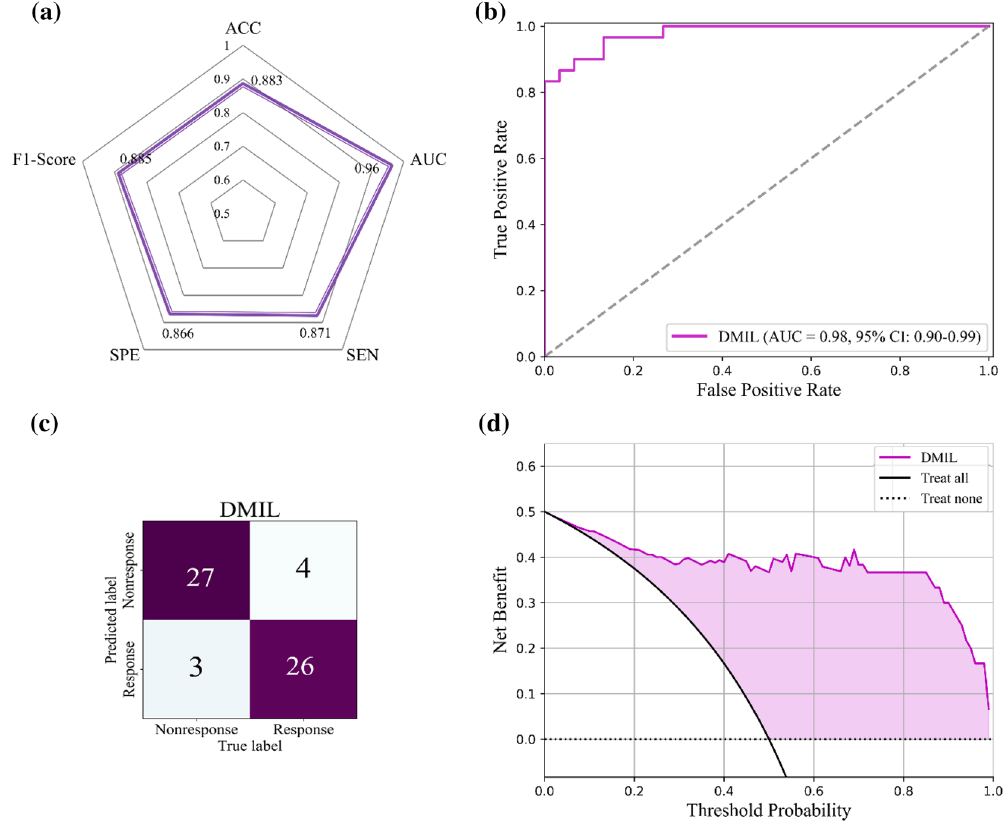
Figure 4. Performance of the DMIL model in the test cohort. ( a ) Statistical results; ( b ) The ROC curve; ( c ) The confusion matrix; ( d ) The DCA result.